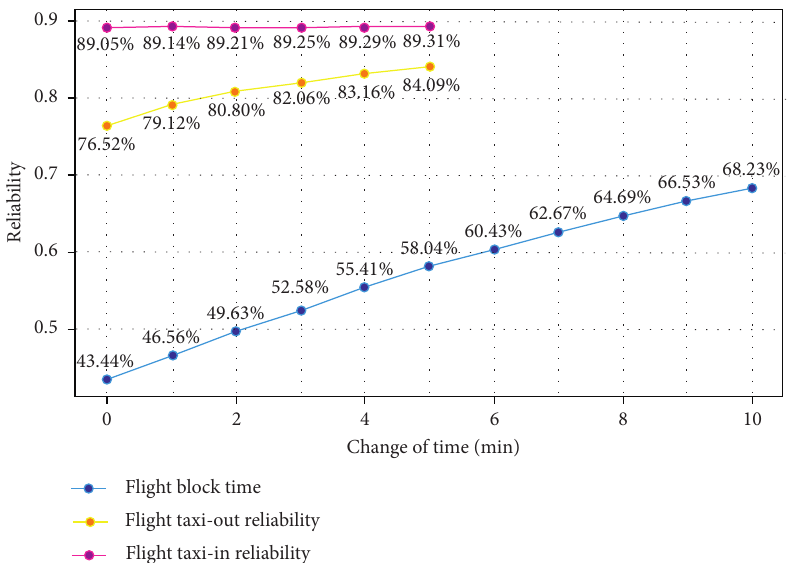
Figure 3: Reliability of flight block time, flight taxi-in time, and flight taxi-out time with the change of standard times, respectively.